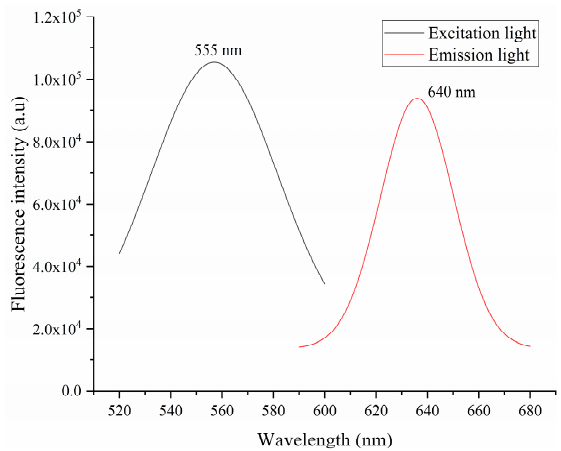
Figure 7. Excitation and emission spectra of the aflatoxin B1 (AFB1) test strip.